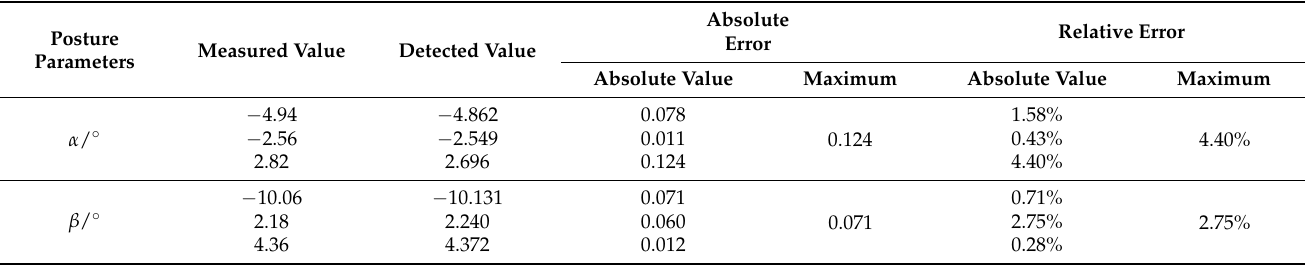
Table 5. Posture parameters detection of camera (characterizing welding torch) relative to weld- ing